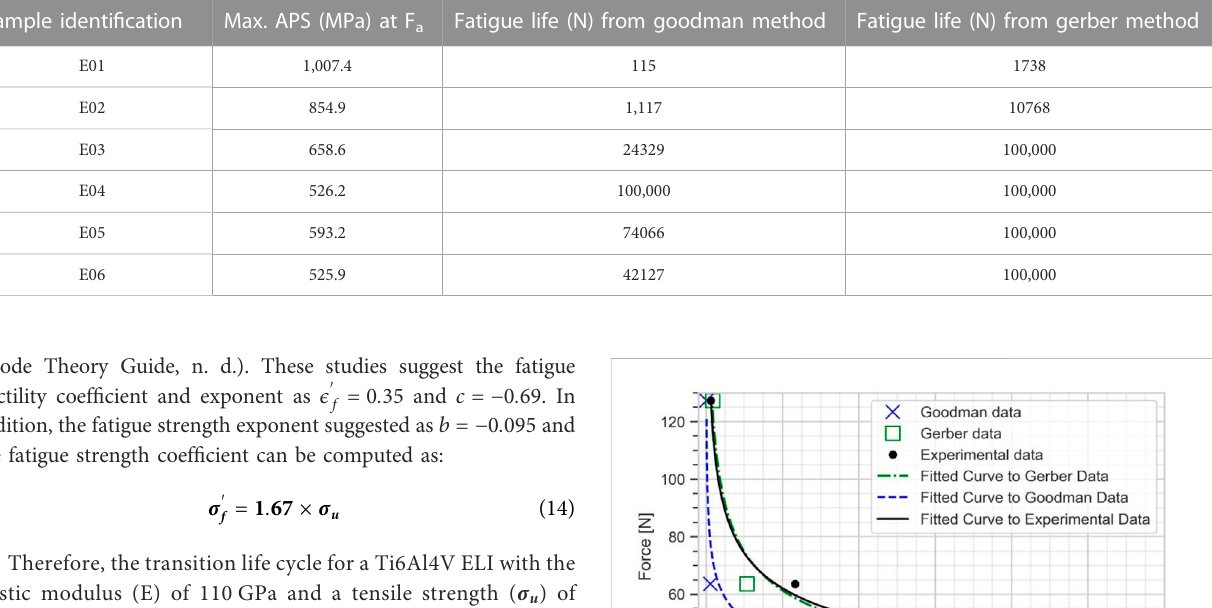
TABLE 5 Maximum APS from elasto-plastc fi nite element model and computed fatigue life. Sample identi fi cation